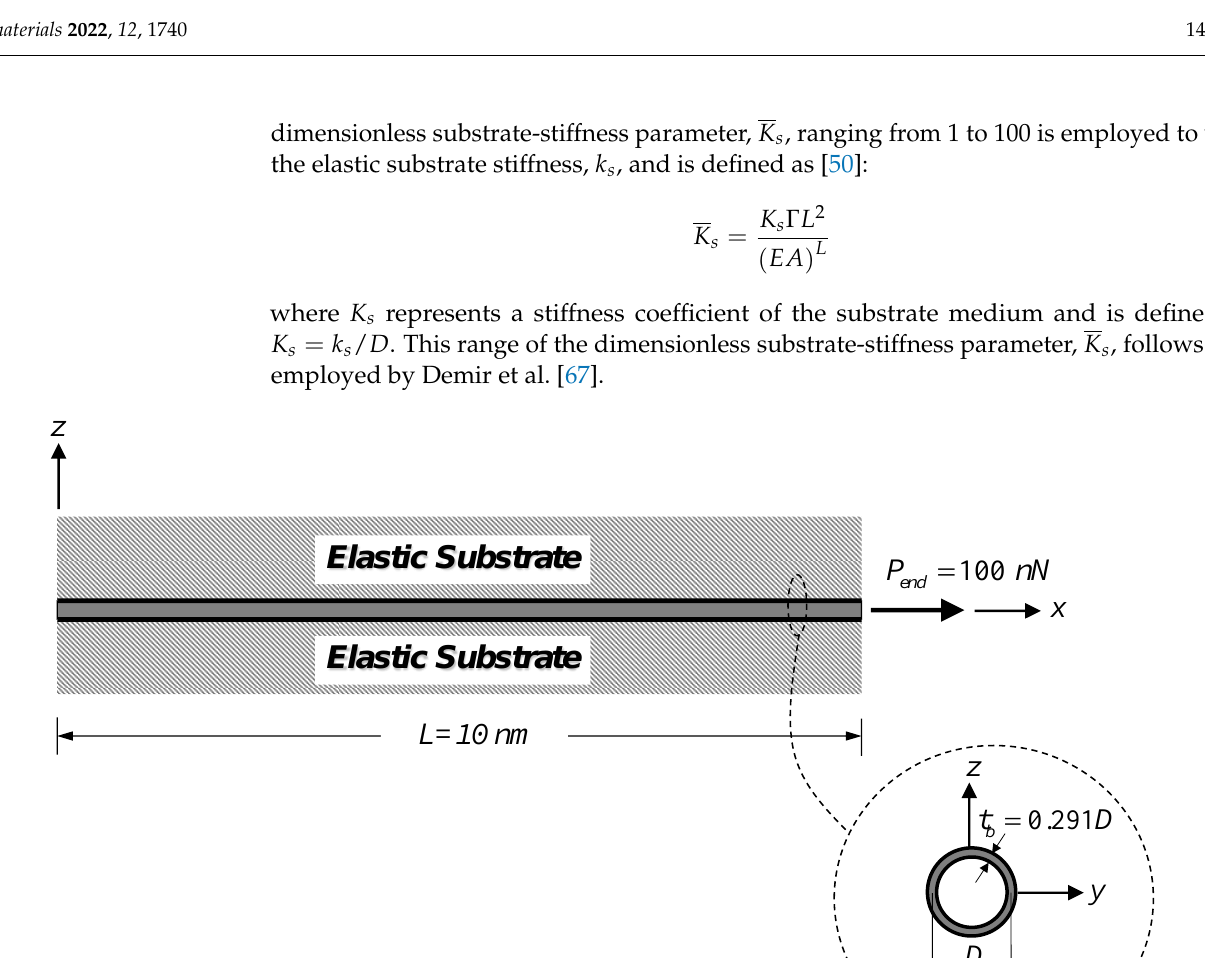
dimensionless substrate-stiffness parameter, K s , ranging from 1 to 100 is employed to vary the elastic substrate stiffness, k s , and is defined as [50]: